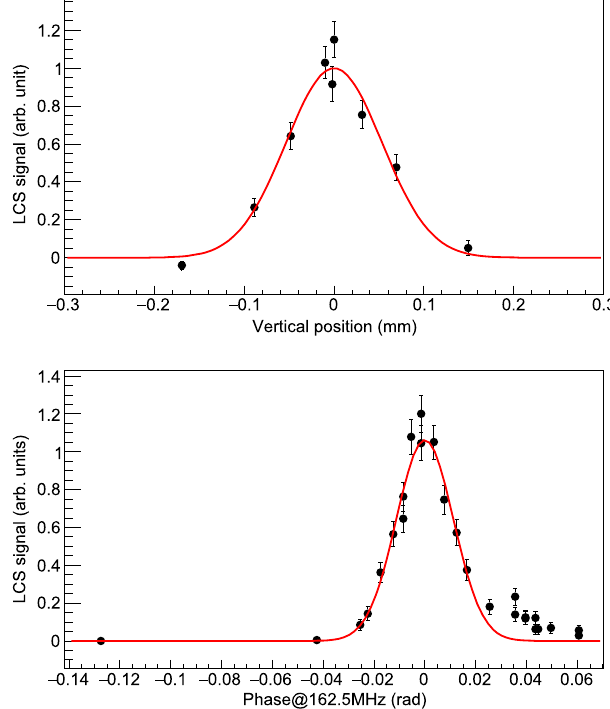
FIG. 24. LCS signal rate as a function of the vertical position of the laser beam (top) and timing of laser phase